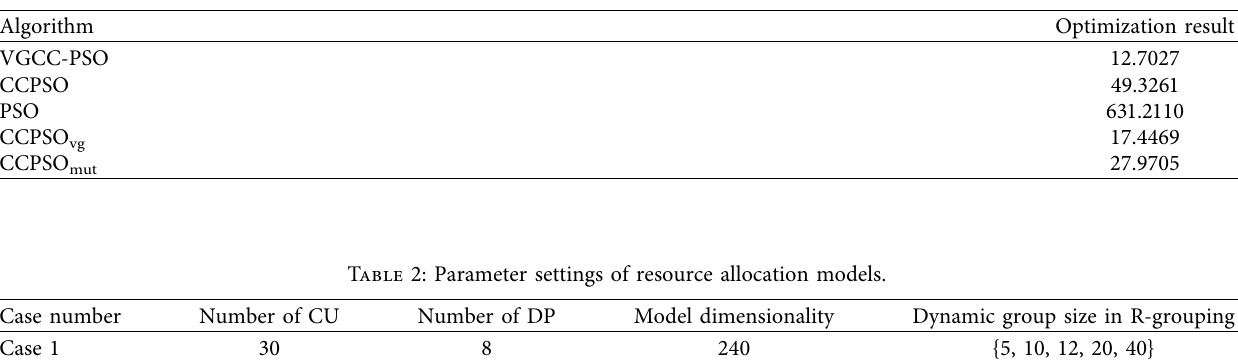
Figure 5: Convergence graphs for optimizing the 1600-dimensional model. Table 1: Optimization results of the compared algorithms.